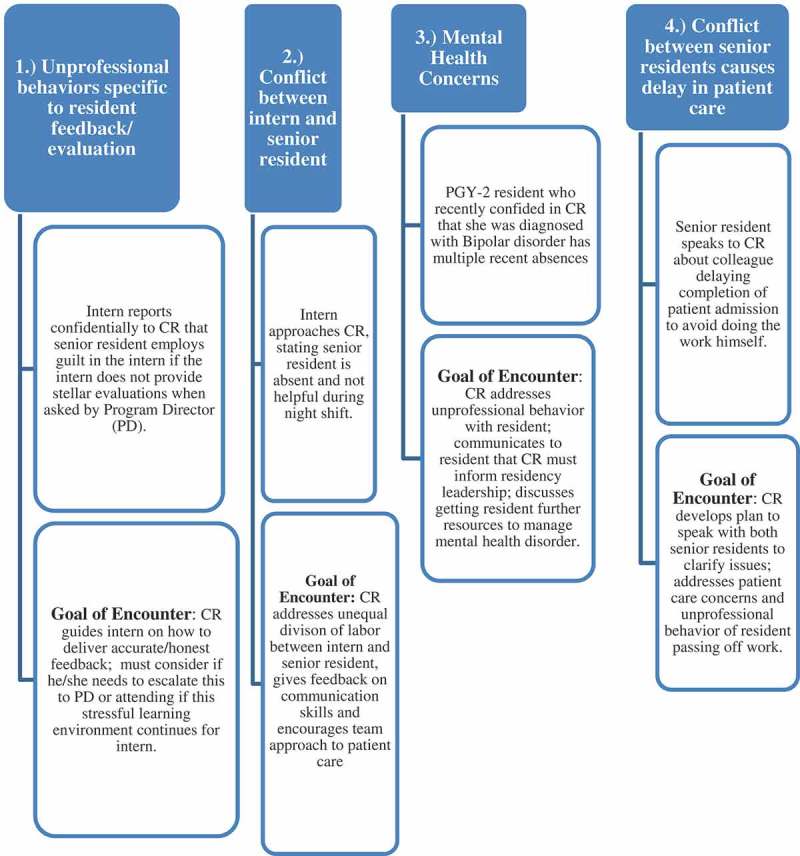
Sample OSTE content.